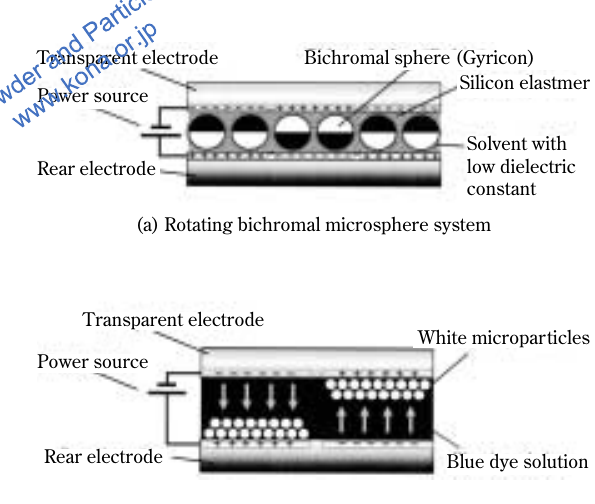
Schematic illustration of the rotating bichromal micros- phere system (a) and the electrophoretic image